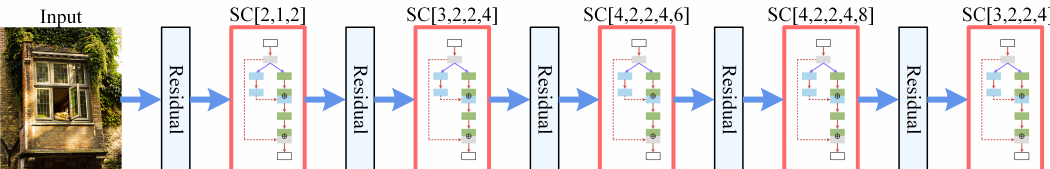
Figure 3. The structure of the SC-59 network which consists of five SC blocks and five residual blocks. We employ residual blocks to complete downsampling operations. The output of the last three SC blocks is extracted to construct a feature pyramid network.